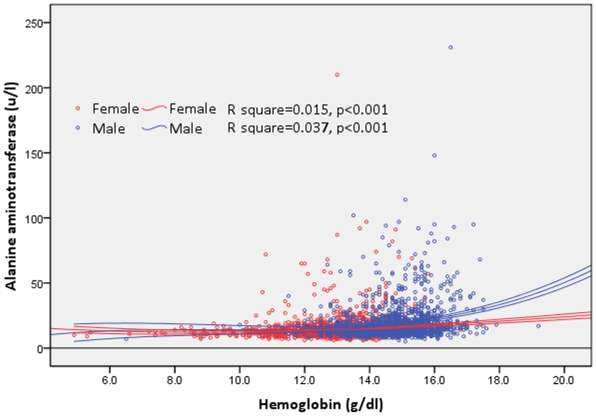
The distribution of alanine aminotransferase (ALT) levels by hemoglobin levels among 3547 adolescents.Two fitting regression lines of two genders are drawn by cubic equation with statistical significance, p<0.001.